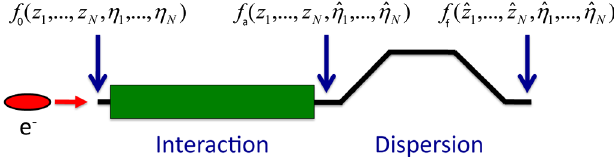
FIG. 1. Schematic of our model system. Starting with an initial electron distribution function f dispersive regions produce a final distribution function z; ^ (cid:1) Þ . The dispersion may be positive or f f ð ^